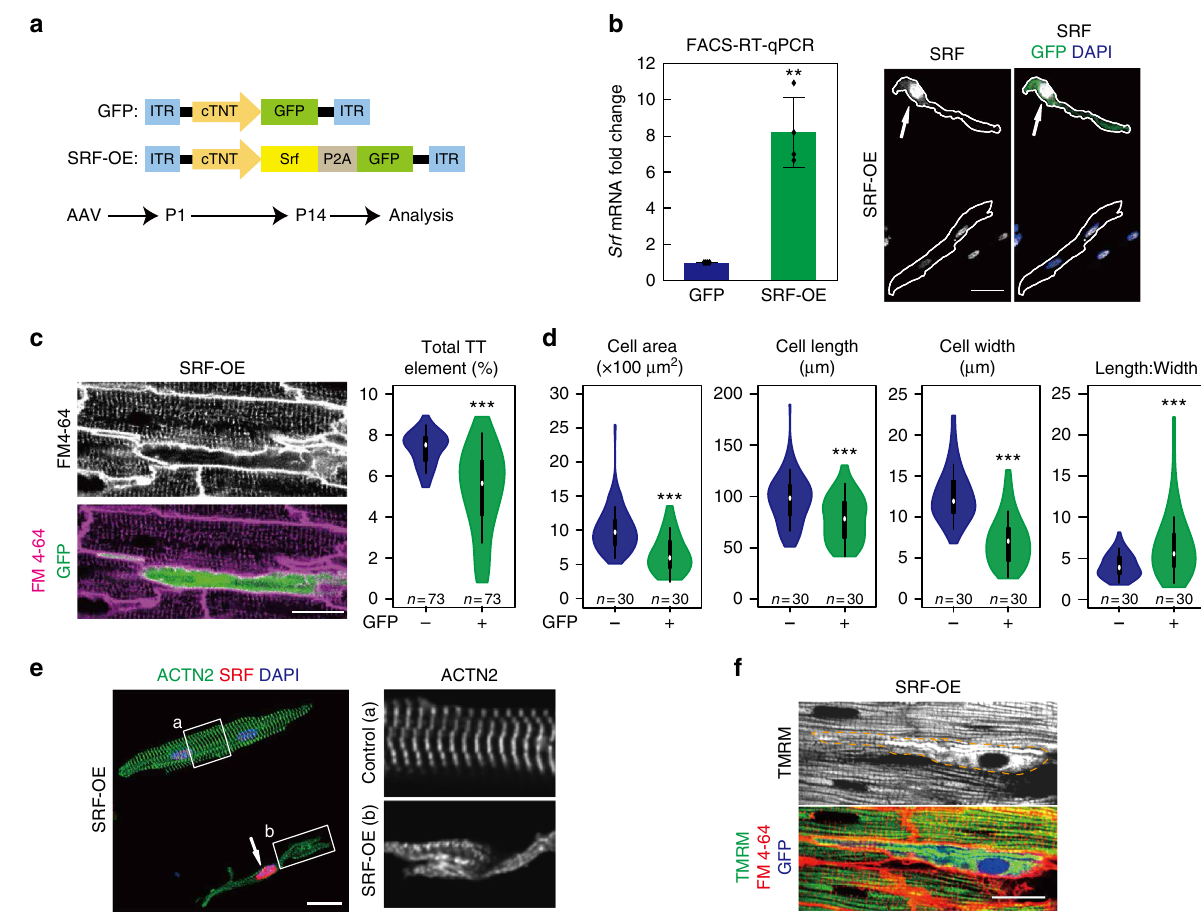
Fig. 7 SRF overexpression perturbs CM maturation. a Schematic design of AAVs overexpressing SRF (SRF-OE) or GFP (control). AAVs were injected into P1 pups. Analysis of maturation was performed at P14. b RT-qPCR of FACS-sorted P14 GFP + CMs validated Srf overexpression (left, n = 4 hearts). Immuno fl uorescence con fi rmed nuclear localization of overexpressed SRF proteins in GFP + CMs (right). Cell boundaries are delineated by white lines. c SRF overexpression disrupted T-tubulation. T-tubule organization was measured by in situ imaging (left) and AutoTT quanti fi cation (right). SRF- overexpressed CMs were labeled by GFP. d SRF overexpression disrupted maturational hypertrophic growth of CMs. e Sarcomere disorganization in CMs overexpressing SRF. Dissociated CMs were stained for ACTN2. Boxed areas are enlarged (right). Arrow points to a validated SRF (red) overexpressing CM. f SRF overexpression caused mitochondrial disorganization. Mitochondria were imaged in situ by TMRM staining. GFP − cells (no blue pseudocolor) had highly organized arrays of mitochondria, unlike the mitochondrial staining pattern in GFP + cells (cell boundary delineated). Scale bars, 20 μ m in all images. Violin plots are described in Fig. 2. Bar plots show mean ± SD and are overlaid by dot plots. Two-tailed Student ’ s t test: ** P < 0.01, *** P <